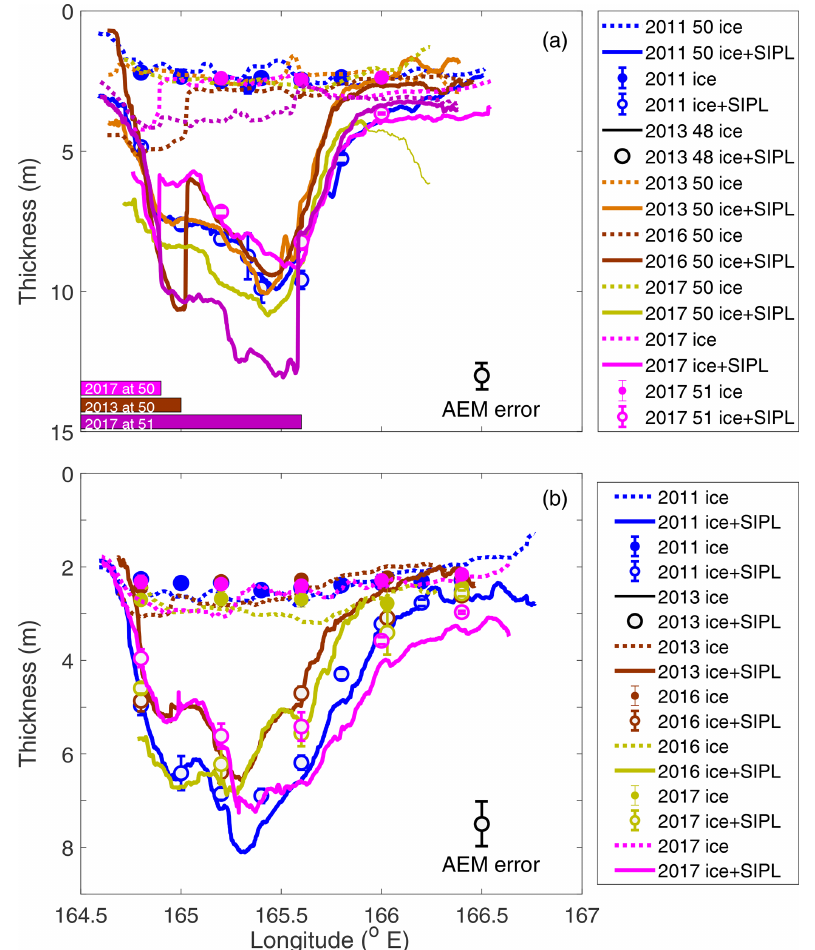
Figure 9. Interannual variability of AEM-derived and drill-hole-consolidated ice h i (stippled lines and filled symbols) and total thickness h i + h sipl (solid lines and open symbols) along E–W transects at similar latitude (median filtered). (a) Transects at approximately 77 ◦ 48 (cid:48) to 77 ◦ 51 (cid:48) S in November 2011, 2013, 2016, and 2017, approximately 3 to 5km from the McMurdo Ice Shelf front. Horizontal bars indicate very thick MY ice present in the west along part of the profiles in 2013 and 2017. (b) Transect at approximately 77 ◦ 46 (cid:48) S in November 2011, 2013, 2016, and 2017, approximately 11km from McMurdo Ice Shelf front. Note different y axis scales, i.e. thicker SIPL farther south. The data reduction model uncertainty in AEM total thicknesses (snow + ice + SIPL) is